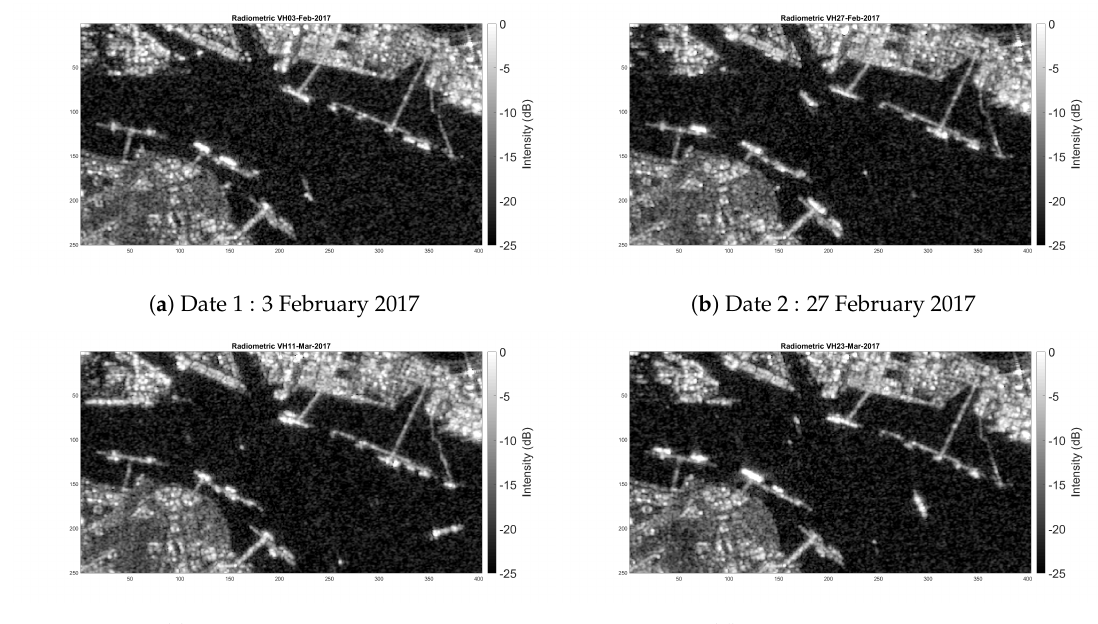
Figure A3. Mask used to exclude change from the land.